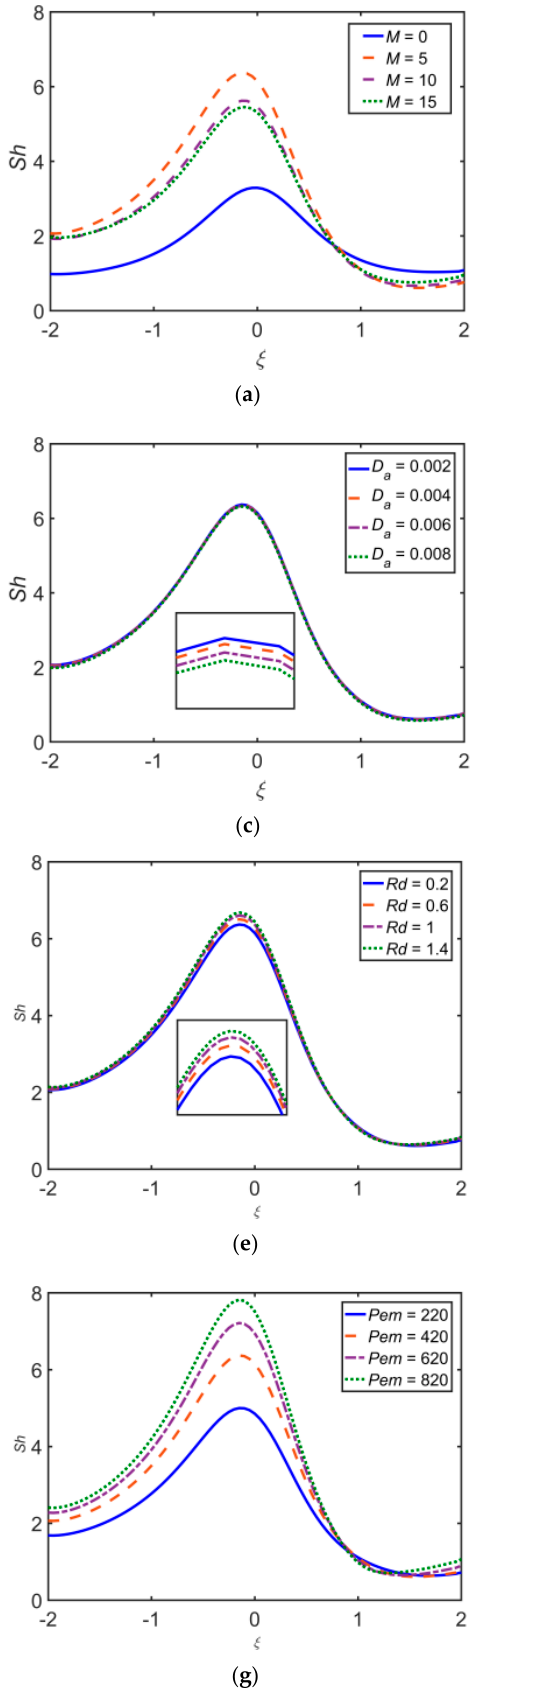
Figure 14. Impact of ( a ) 𝑀 , ( b ) 𝛽 , ( c ) 𝐷 (cid:3028) , ( d ) 𝑃𝑒ℎ , ( e ) 𝑅𝑑 , and ( f ) 𝑅𝑒 on 𝑁𝑢 . Figure 15 depicts the influence of different flow governing parameters on the Sher- wood number 𝑆ℎ . It is observed that 𝑆ℎ escalates as 𝛽 , 𝑅𝑑 , 𝑅𝑒 , and 𝑃𝑒𝑚 estimations intensify, whereas 𝑆ℎ reduces upon escalating 𝐷 (cid:3028) , 𝑀 , 𝑃𝑒ℎ , and 𝑆𝑟 .